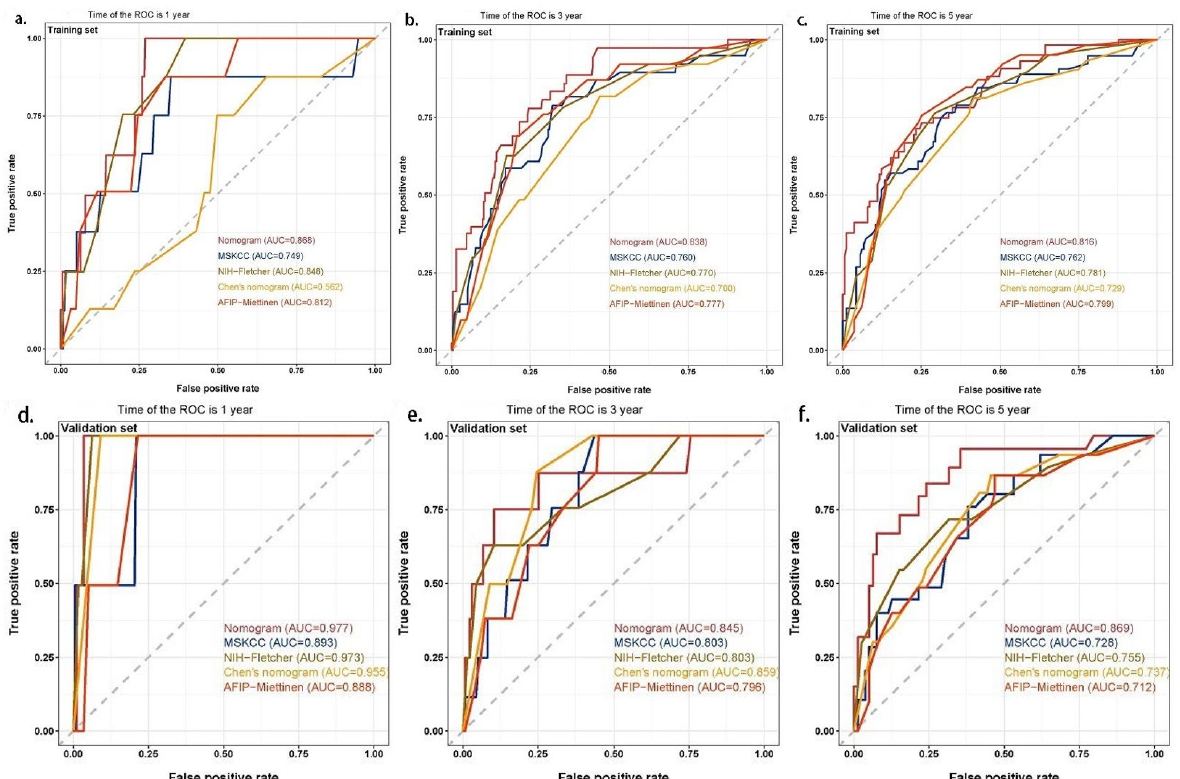
Figure 4. ROC curves for each prognostic scoring system to predict the RFS of patients with GISTs. ( a ) The 1-year ROC curves in the training set. ( b ) The 3-year ROC curves in the training set. ( c ) The 5-year ROC curves in the training set. ( d ) The 1-year ROC curves in the validation set. ( e ) The 3-year ROC curves in the validation set. ( f ) The 5-year ROC curves in the validation set.